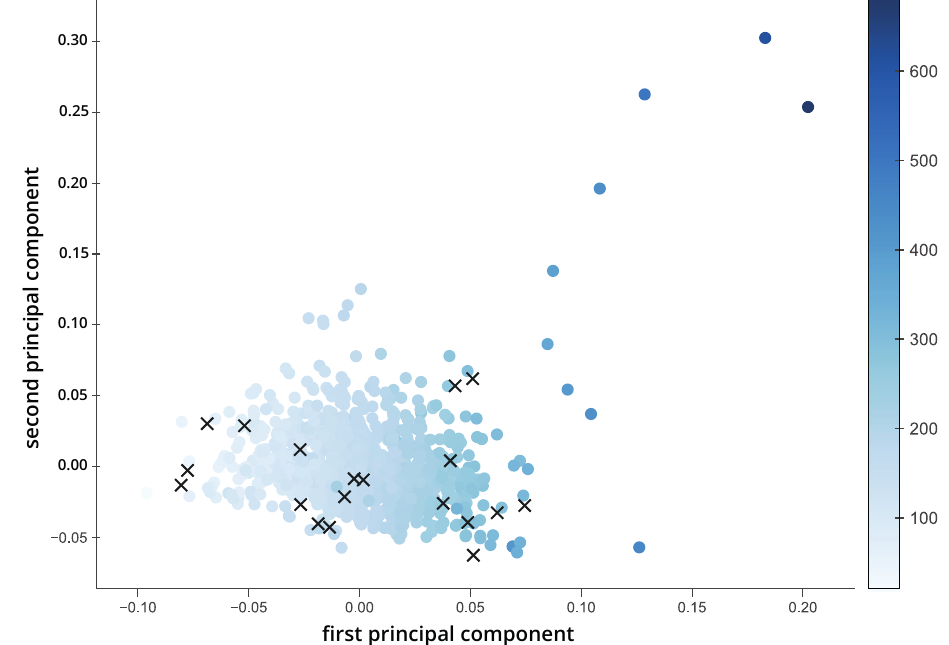
Figure 2. Physicochemical Odor Space. The graph shows the values for the first two principal components as obtained from dimension reduction of the physicochemical molecule properties for 1389 odor molecules. The 20 odor molecules used in the further analyses are highlighted as “x”. The shade of blue indicates the molecular weight of the molecule